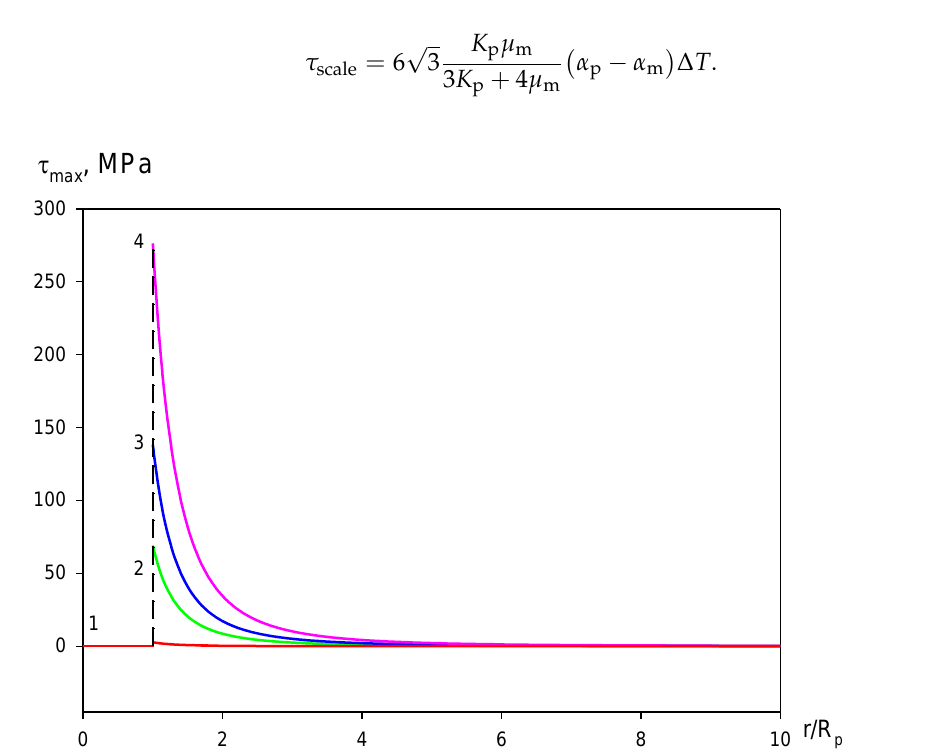
Figure 8. The distribution of the maximal shear stresses σ rr in the particle and matrix for various values of the temperature difference: 1 —ΔT = 10 K ; 2 — 50 K; 3 — 100 K; 4 — 200 K.